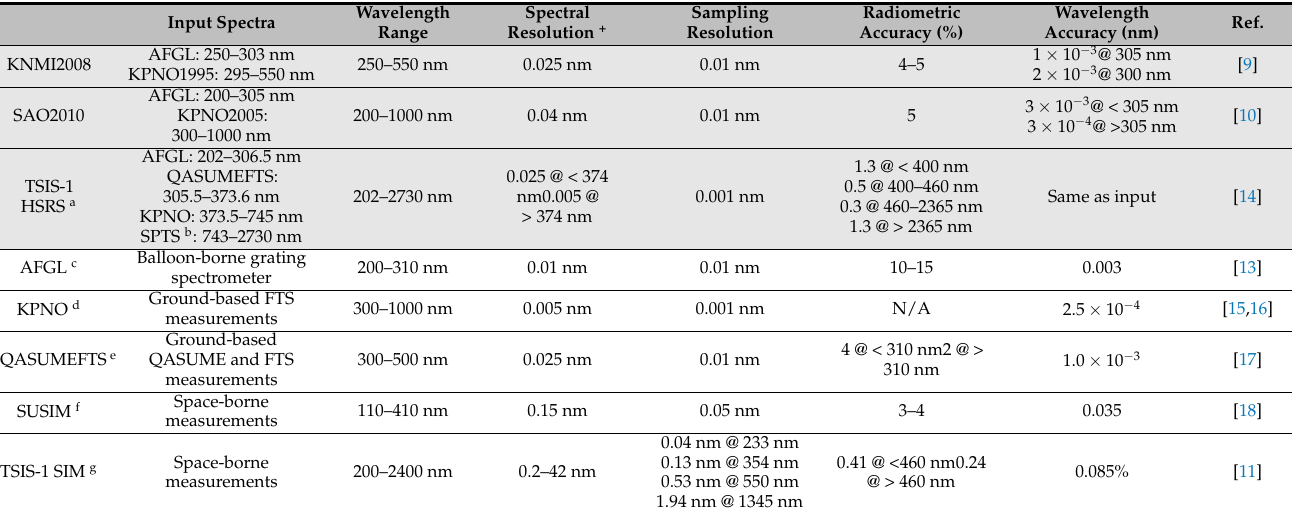
Table 1. Main characteristics of the three high-resolution solar reference datasets (rows 1–3) and their input spectra (rows 4–8) in the UV and visible